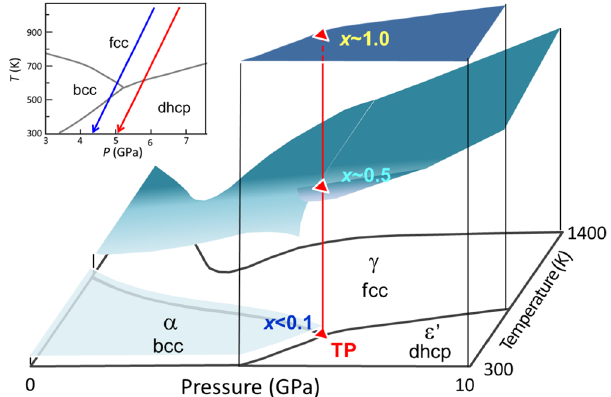
Figure 1. Schematic of the x–T–P diagram of the Fe–H system: the inset is a projection onto the T–P plane showing T–P paths used in X-ray (red arrow) and neutron (blue arrow) diffraction